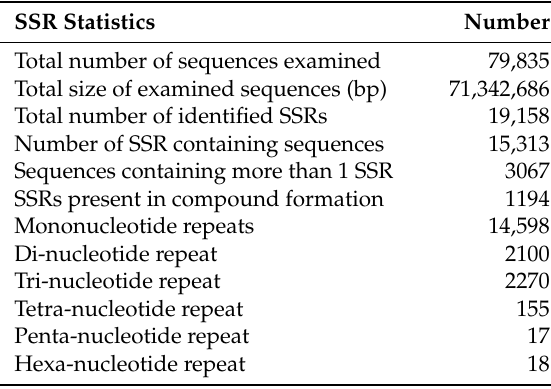
Table 6. Statistics of simple sequence repeats (SSRs) identified from C. arachnoidea transcriptome data. SSR